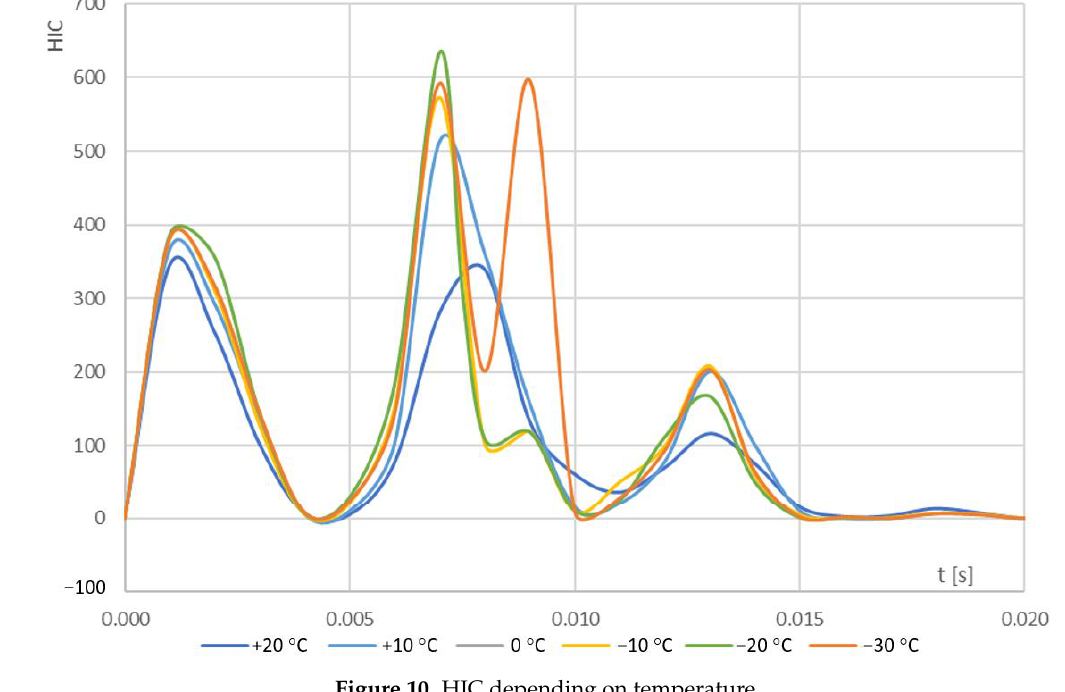
Figure 10. HIC depending on temperature.